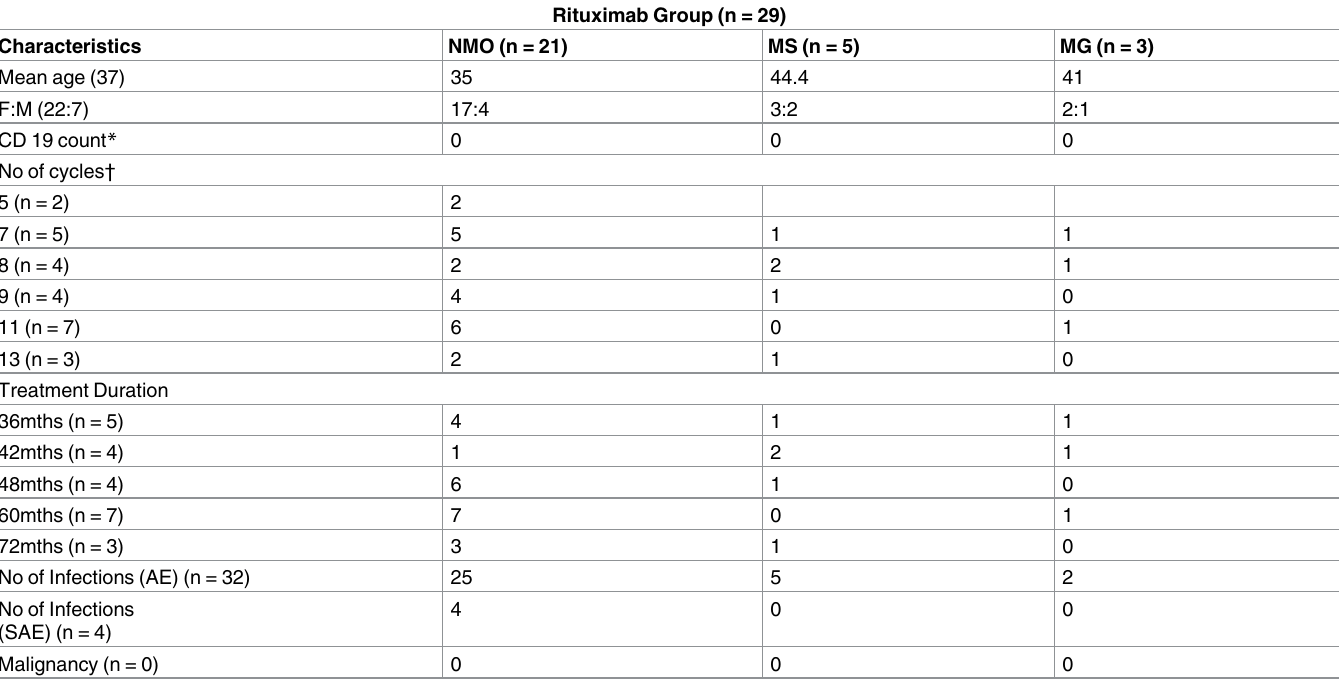
Table 1. Summaryof demographical data, rituximab treatments, and adverseevents.